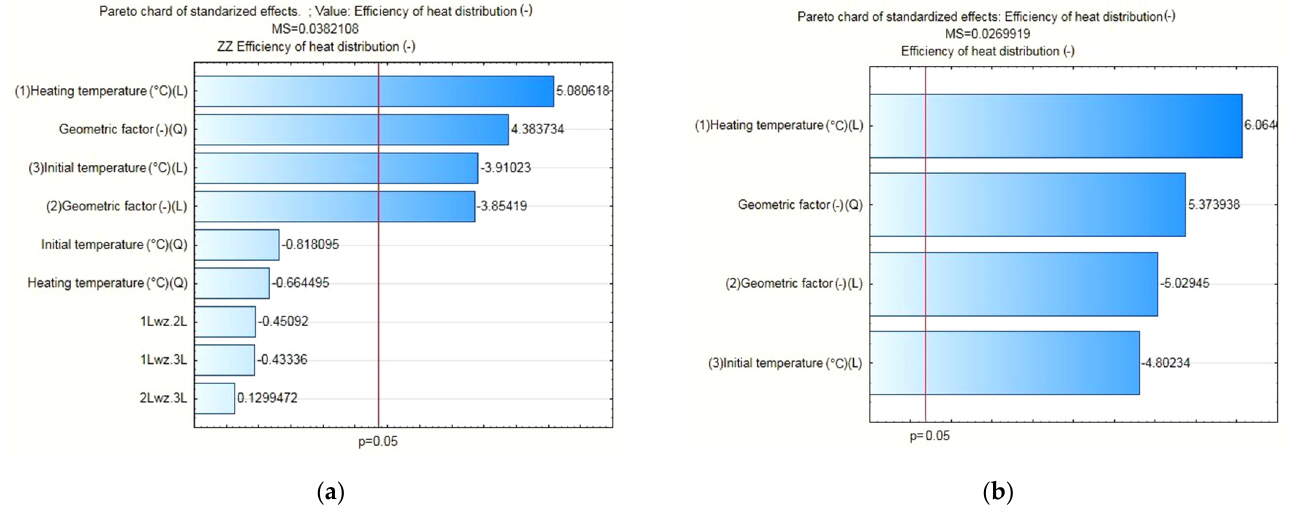
Figure 13. ( a ) Pareto chart for all input quantities of interest and their correlation to the output quantity value; ( b ) Pareto chart for the statistically significant input quantities, applicable to the PCM/coke recyclate heat accumulator.